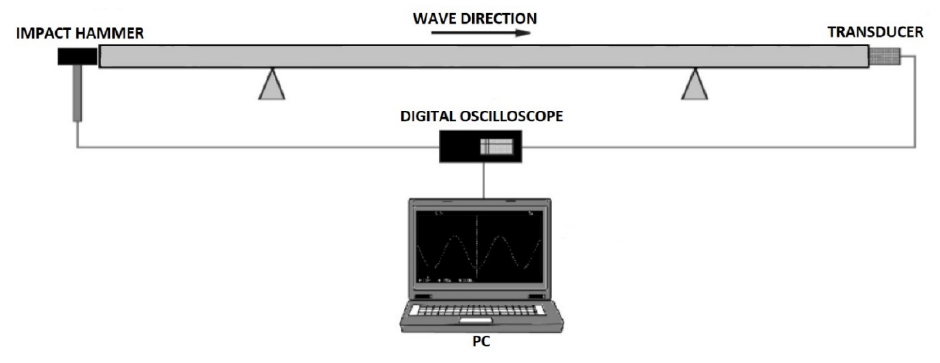
Figure 3. Test schematic.